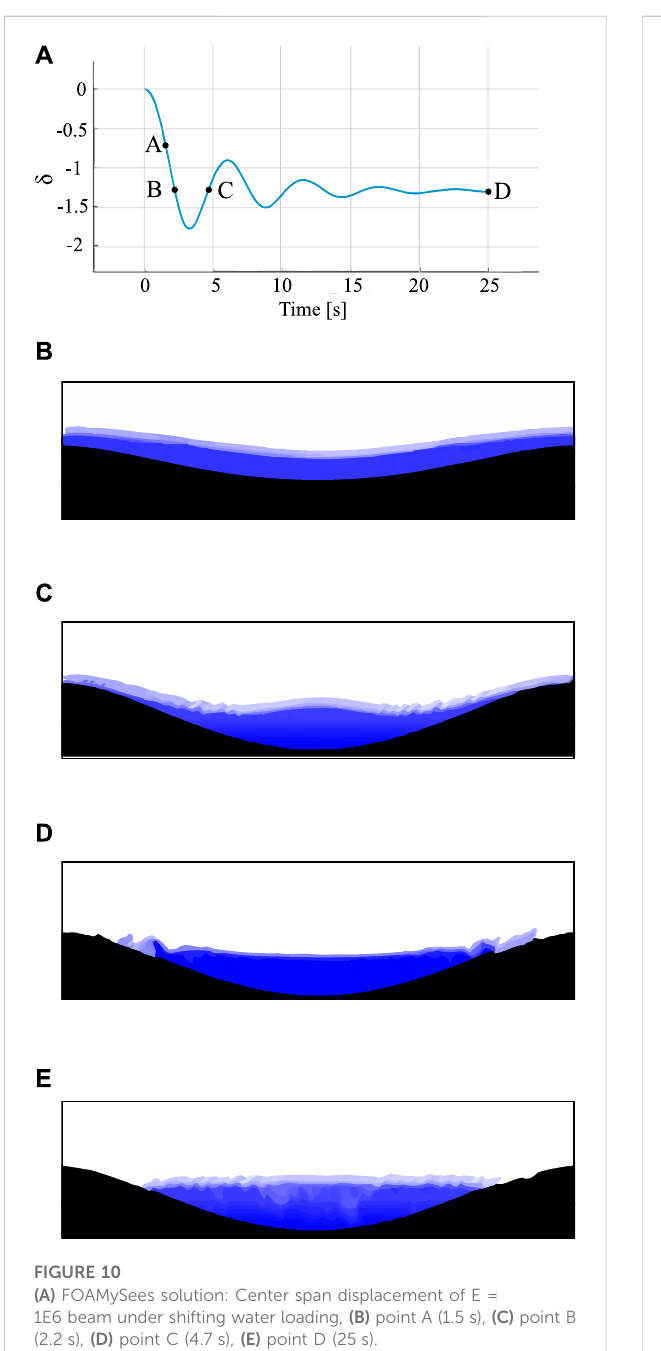
1.0 g/cm 3 (1000 kg/m 3 ) and μ 1 = 0.01 g/s/cm while ρ 2 = 0.001 g/cm 3